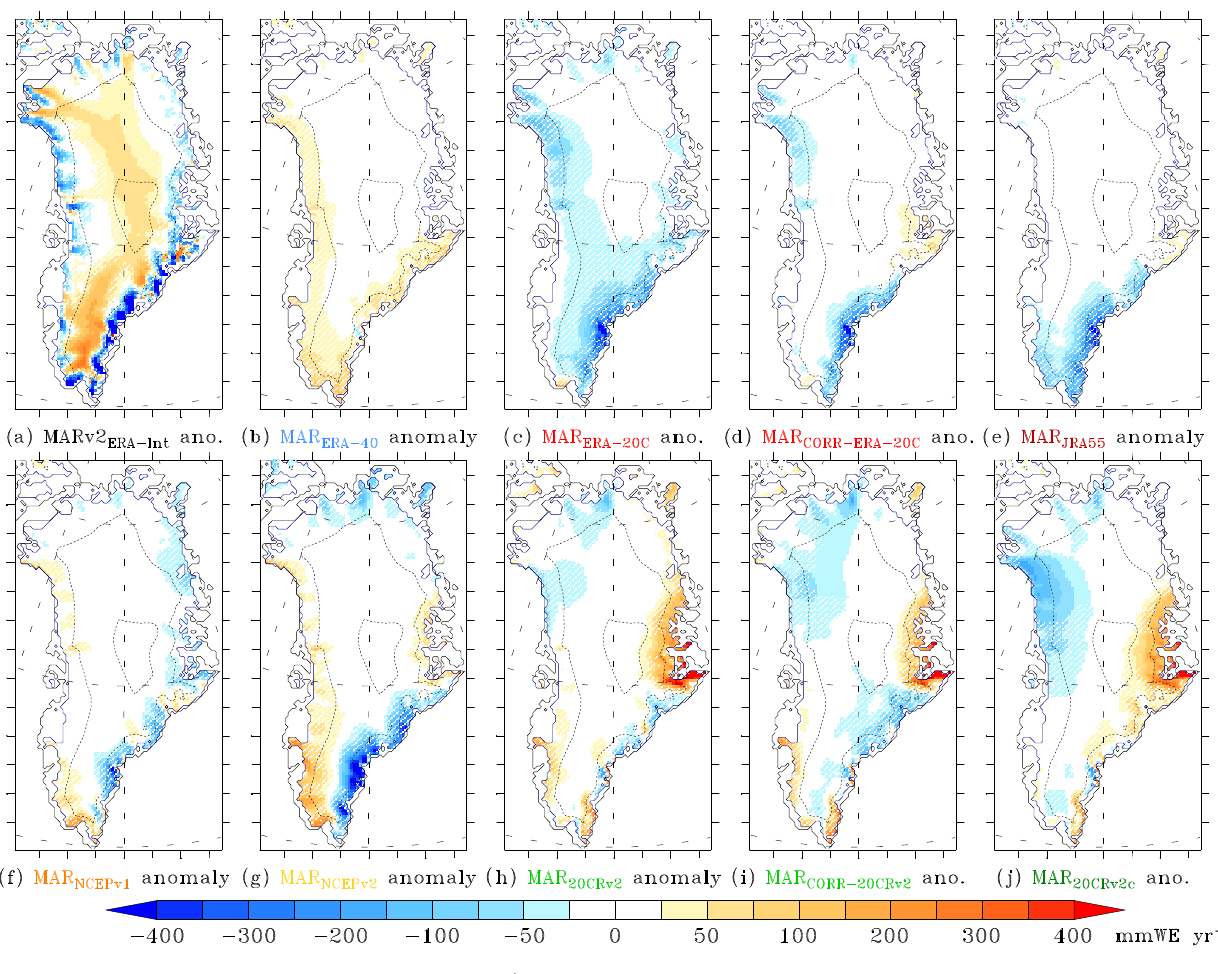
Figure 4. Same as Fig. 3 but for snowfall (in mm.w.e.yr − 1